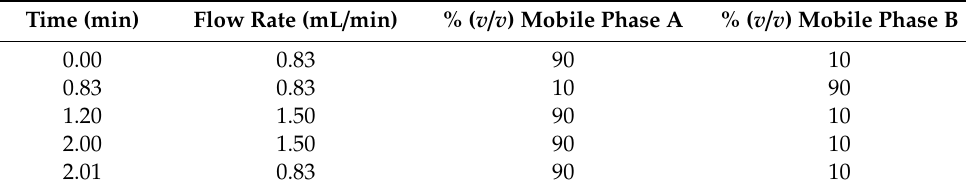
Table 1. UHPLC gradient and flow